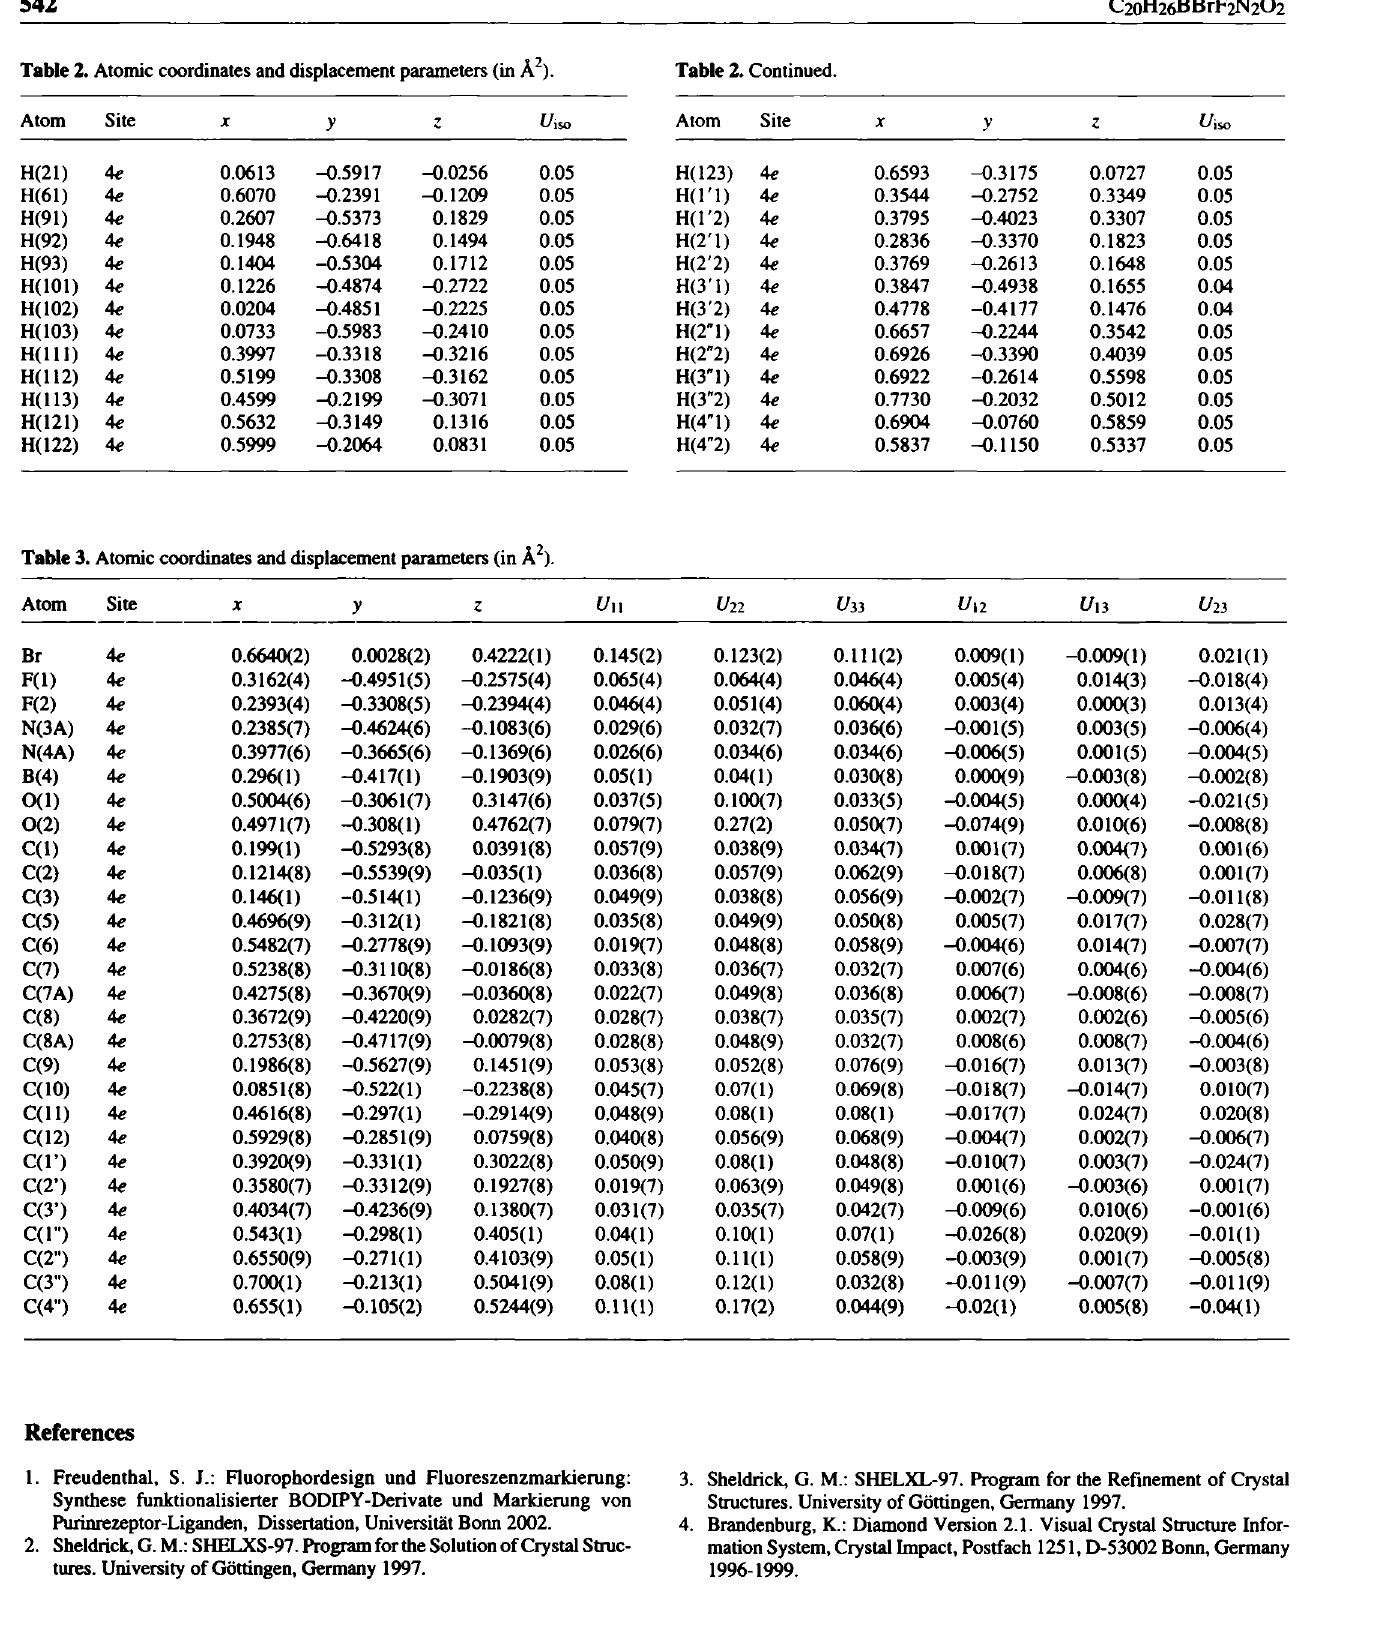
Table 3. Atomic coordinates and displacement parameters (in Â 2